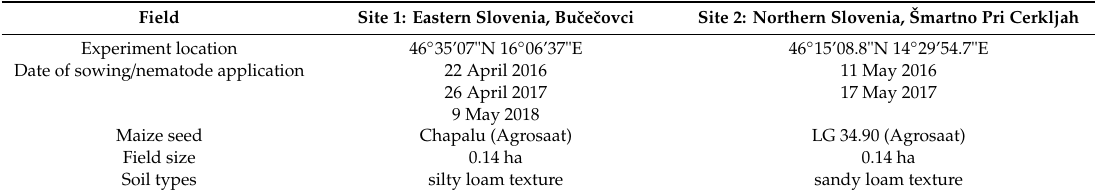
Table 1. Characteristics of the field